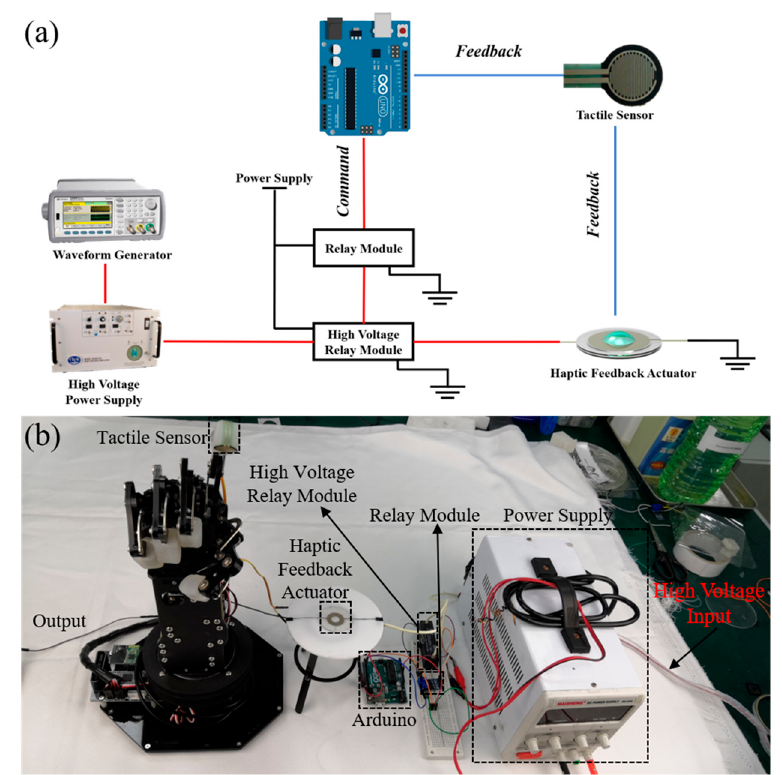
Figure 9. Haptic feedback control system with schematic diagram ( a ) and the photo ( b ).